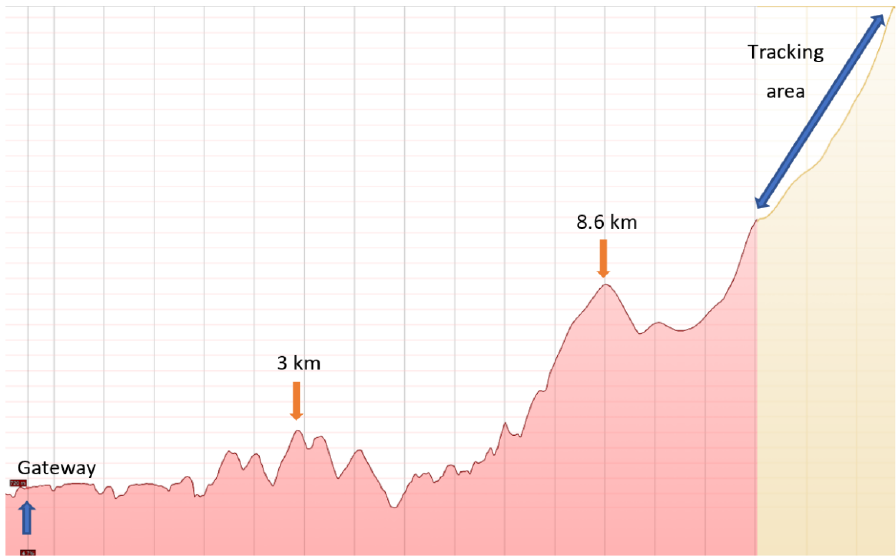
Figure 11. Range and elevation profile.